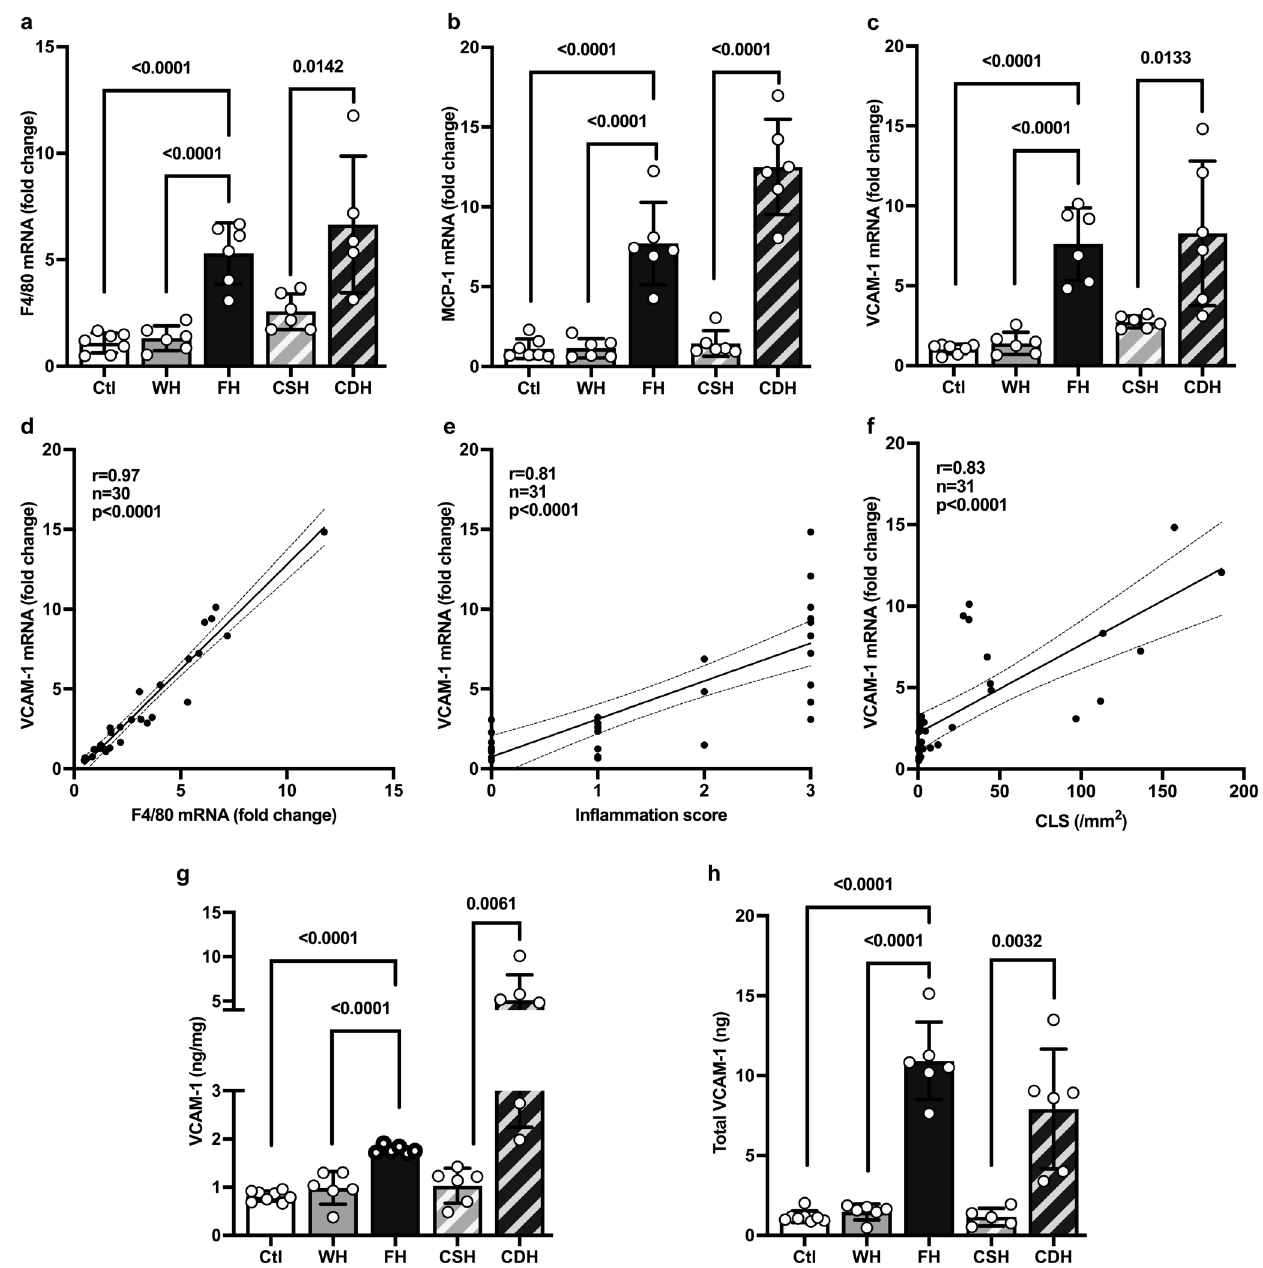
Fig. 4 | VCAM1 expression correlates with in fl ammatory markers. a F4/80, b MCP-1, and c VCAM-1 mRNA fold change (one-way ANOVA and Student ’ s t-test, n =7 for Ctl and n =6 for other groups). Spearman ’ s correlations between VCAM-1 mRNAlevel(foldchangecomparedtohousekeepinggeneRPL19)and d F4/80fold change, e histological in fl ammatory score, and f CLS, respectively. g VCAM-1 pro- teincontentpermgoftissue(one-wayANOVAandStudent ’ st-test, n =8forCtland